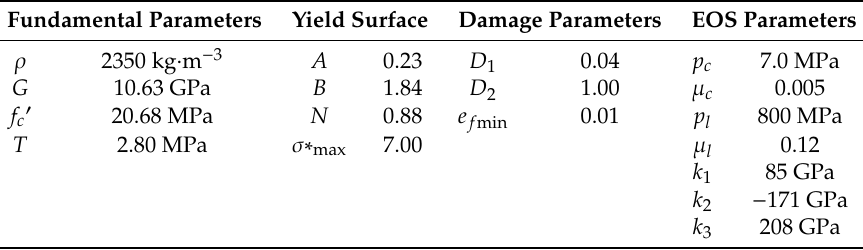
Table 3. HJC model parameters for RCC